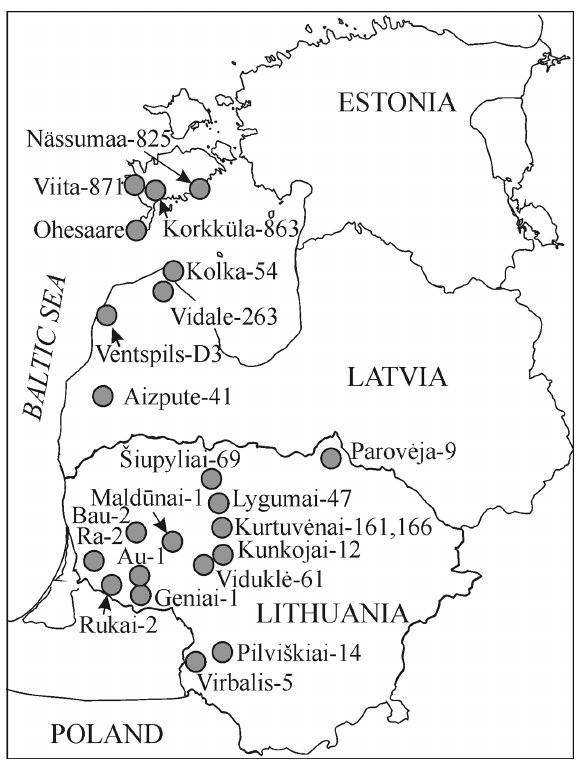
Fig. 1. Location of the studied drill core sections. Ra-2 = Ramu č iai-2, Au-1 = Auk(cid:154)tupiai-1, Bau-2 =